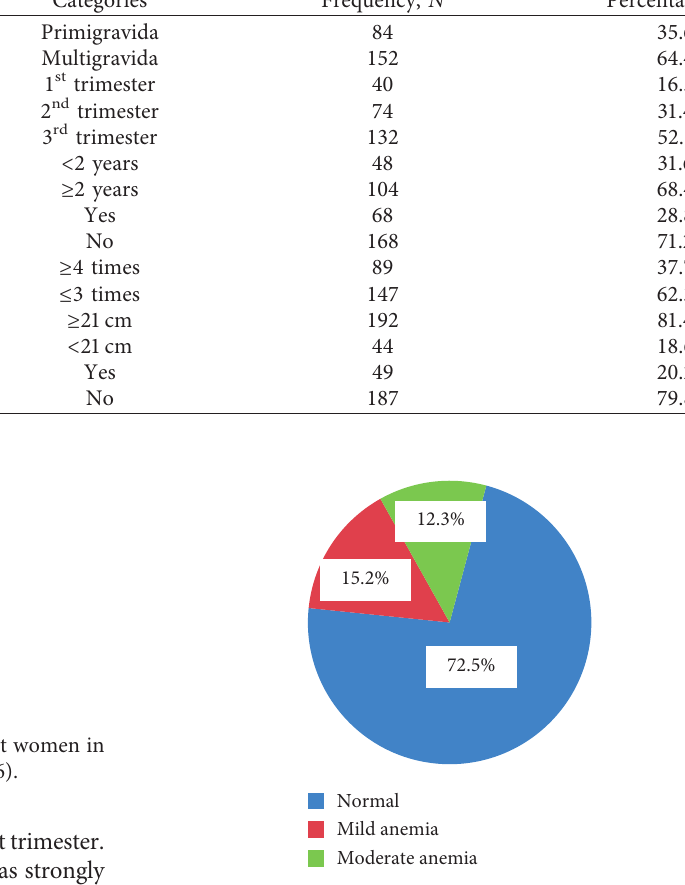
Figure 2: Prevalence of anemia among pregnant women in Kulito Health Center, SNNPR, Ethiopia, 2018 ( n �